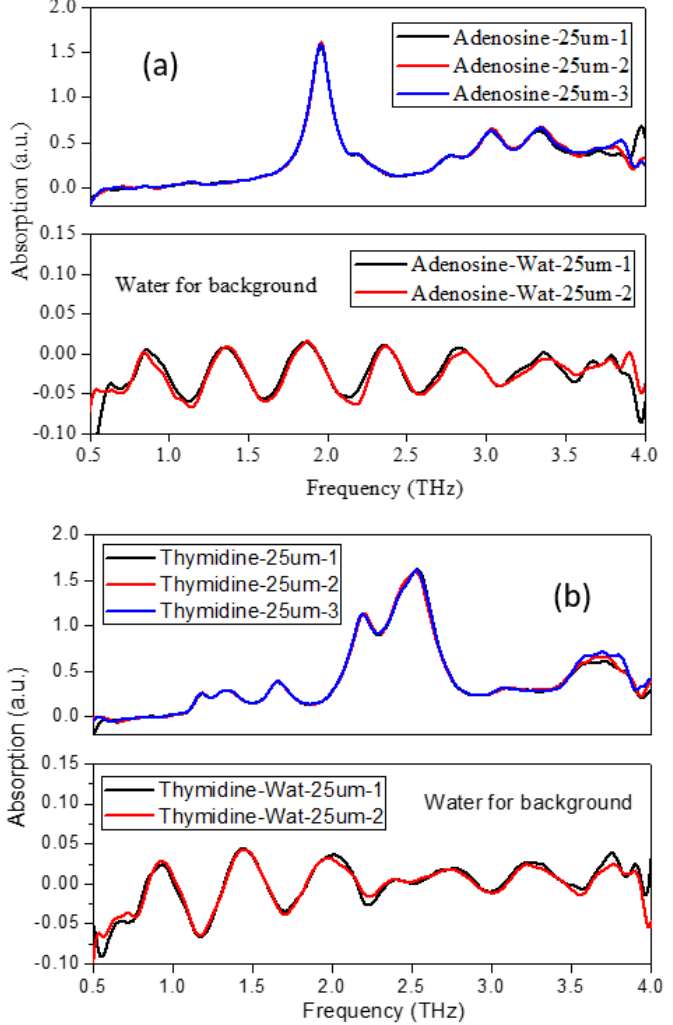
Figure 5. Comparison of THz spectra of solid and liquid samples—( a ) adenosine, ( b ) thymidine—with Figure 6. Comparison of THz spectra of solid and liquid samples — ( a ) adenosine, ( b ) thymidine — water for with water for background.